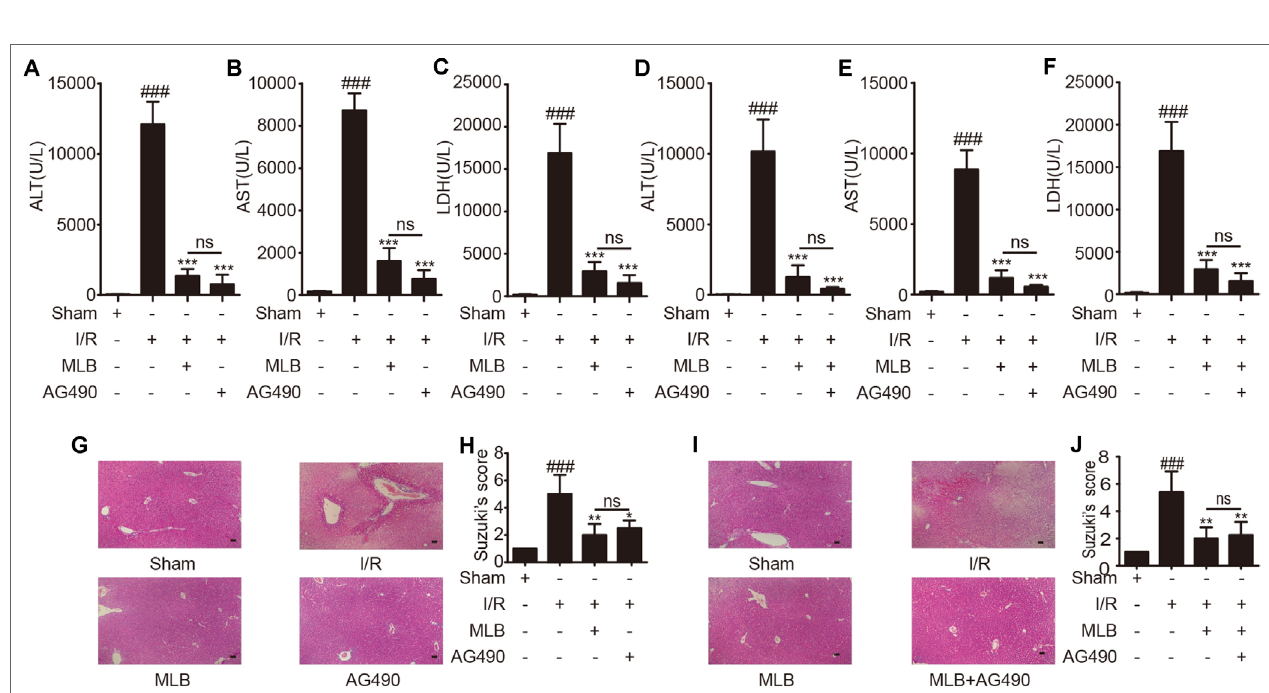
FIGURE 5 | AG490 or MLB+AG490 pretreatment attenuates liver injury caused by ischemia–reperfusion. (A – F) The levels of ALT, AST, and LDH in sham, I/R, MLB, and AG490 or MLB+AG490 groups. (G – J) Classical images of sham, I/R, MLB, and AG490 or MLB+AG490 pretreatment groups were examined by H&E staining, and histopathological score was calculated by Suzuki’s scoring standard, magnification x200, scale bar 50 μ m. Data shown are mean ± SD; n = 3–5 for each group; ns: no statistical significance; ### P < 0.001 versus sham group; *P < 0.05, **P < 0.01, and ***P < 0.001 versus I/R